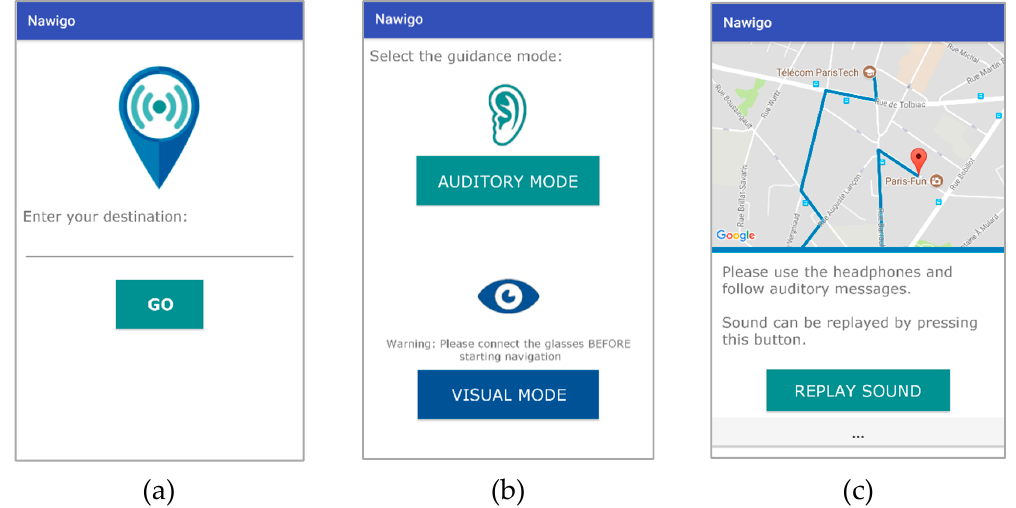
Figure 4 . Screenshots of the application. (a) The welcome screen, (b) the choice of the navigation mode, and (c) the navigation